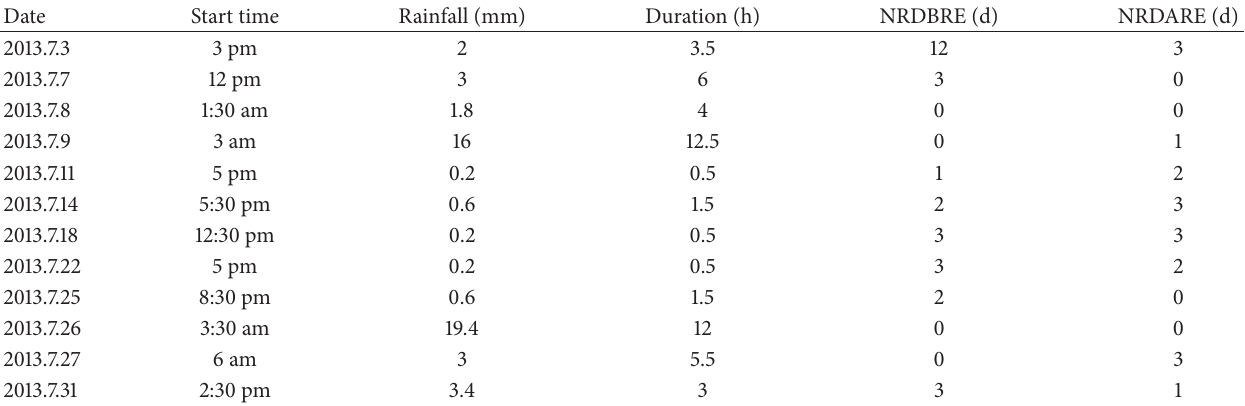
Table 3: Rainfall profile of the study area in July 2013.